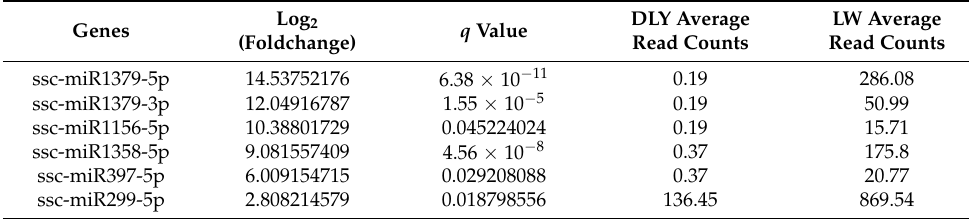
Table 5. The upregulated miRNAs in the Longissimus dorsi muscle of LW pigs.